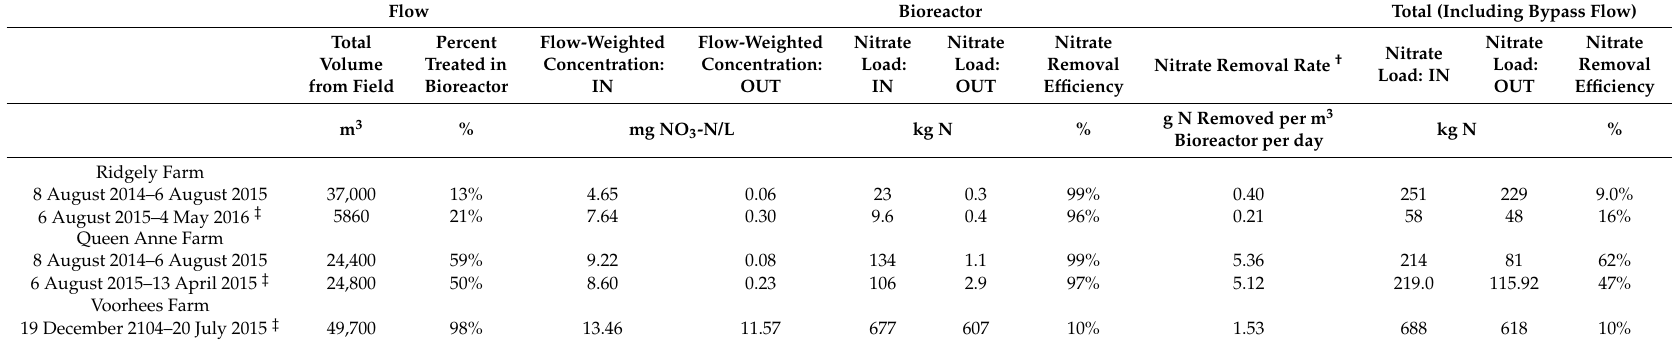
Table 2. Summary of flow treated and nitrate removal within the bioreactor and considering bypass flow (“Total”) for three bioreactors in Maryland.